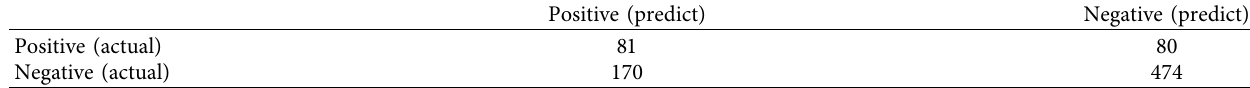
Table 10: Confusion matrix of the updated high precision data set model.